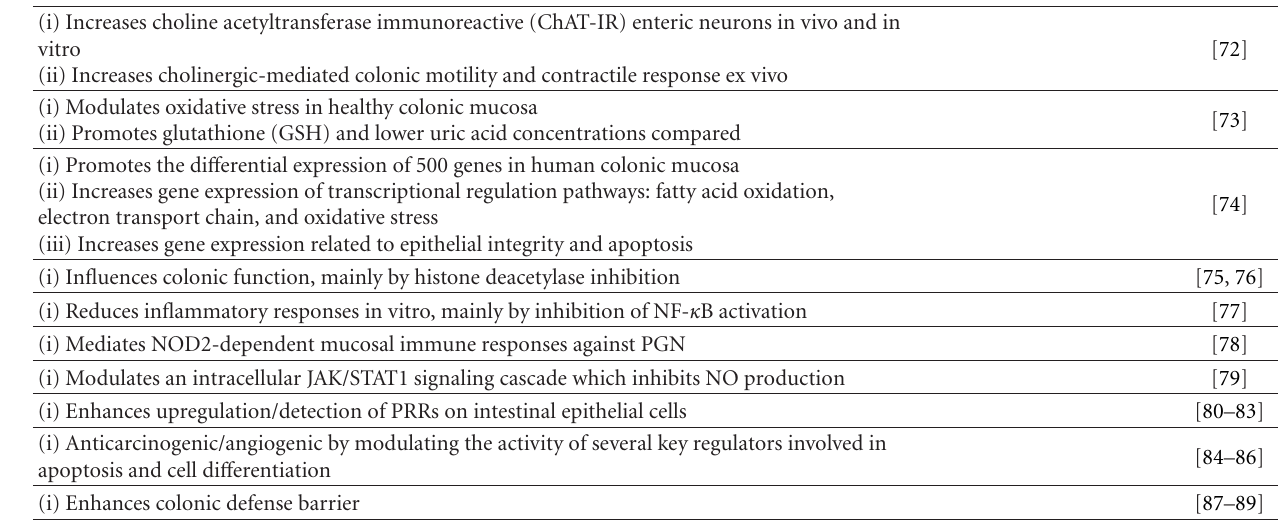
Table 2: Some immunoregulatory functions of